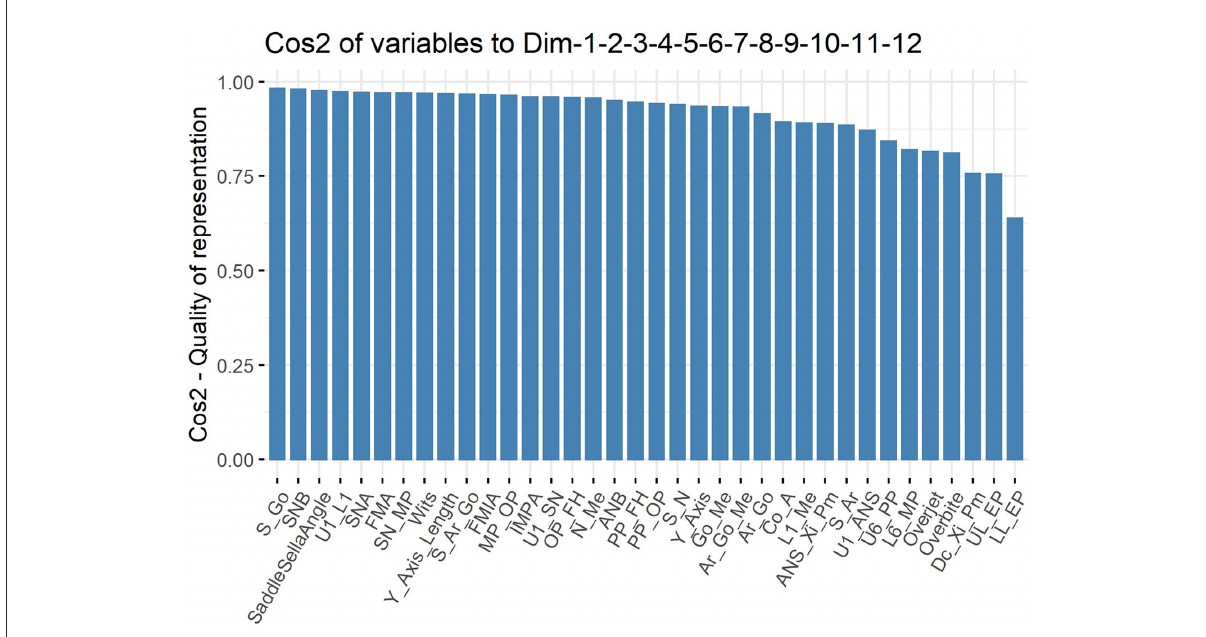
FIGURE5 Cos2 plot. 24 of the 36 cephalometric variables had Cos2 values > 0.9 (66.7%) and 33 were > 0.8